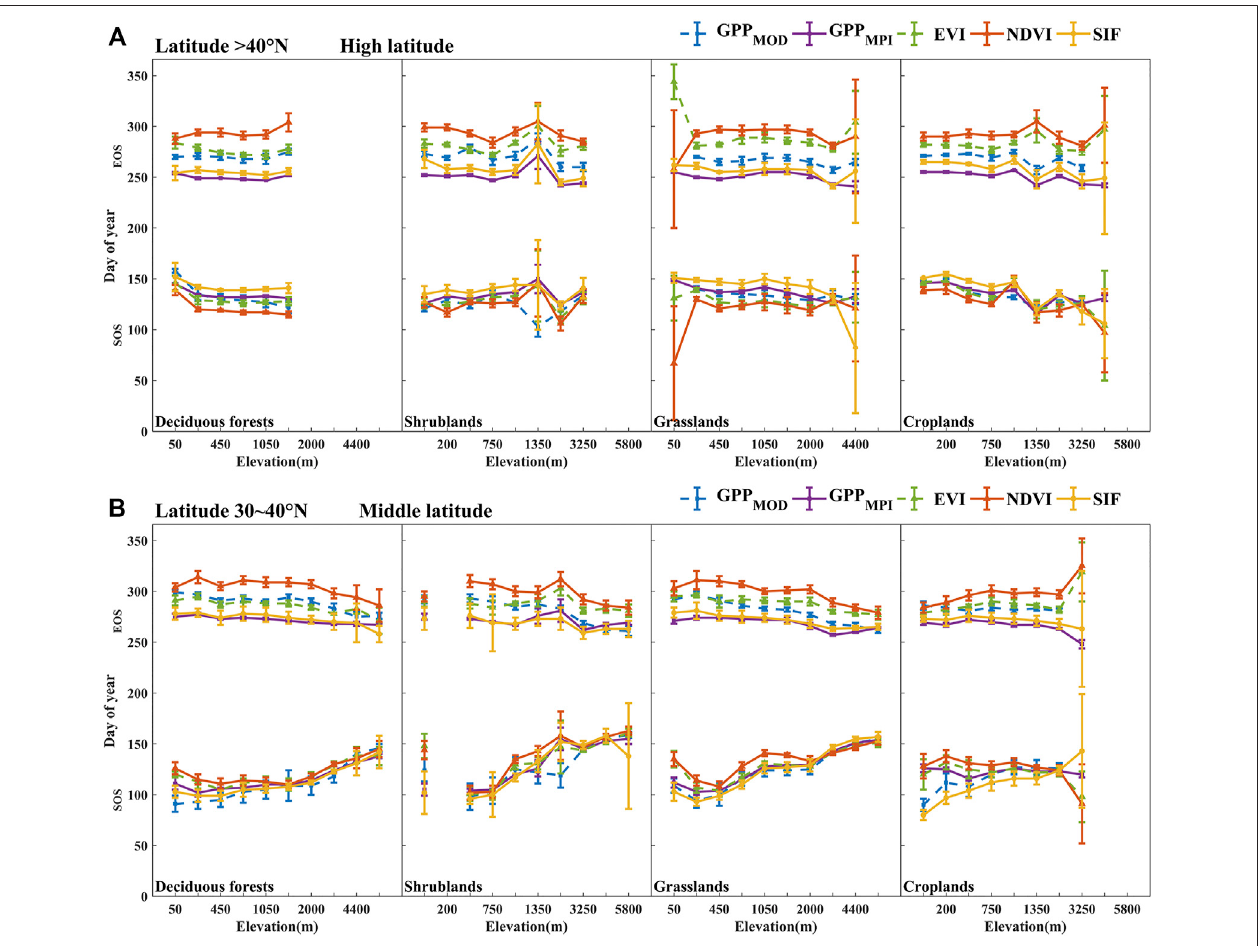
FIGURE 10 | The area-averaged SOS (the lower lines) and EOS (the upper lines) of GPP MOD , GPP MPI , NDVI, EVI, and SIF over deciduous forests, shrublands, grasslands, croplands, and evergreen forests during 2007 – 2013 in high- (A) , middle- (B) , and low- (C) latitude regions. The points and error bars in all fi gures represent the mean and standard deviations for 2007 – 2013,